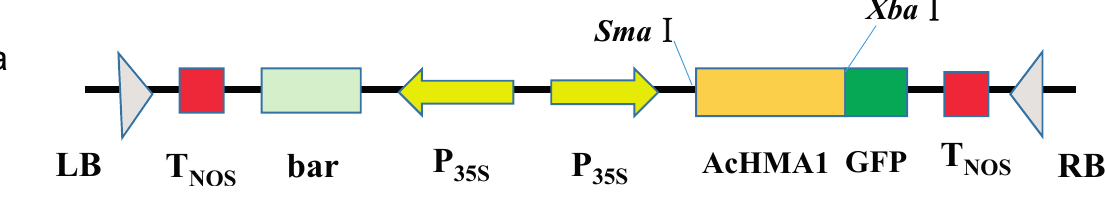
Figure 5. Subcellular localization of AcHMA1-GFP. ( a ) Schematic representation of constructs used for transformation and subcellular localization of the AcHMA1protein; ( b ) Subcellular localization assay of the AcHMA1 protein. Images show N. benthamian a epidermal cells expressing GFP (control, upper lane ) or the AcHMA1:GFP fusion protein ( bottom lane ); bright-field illumination ( left ), followed by fluorescent-field illumination was used to examine GFP fluorescence ( middle ) and confocal microscopy ( right ) for an overlay of bright and fluorescent illumination. Bars = 20